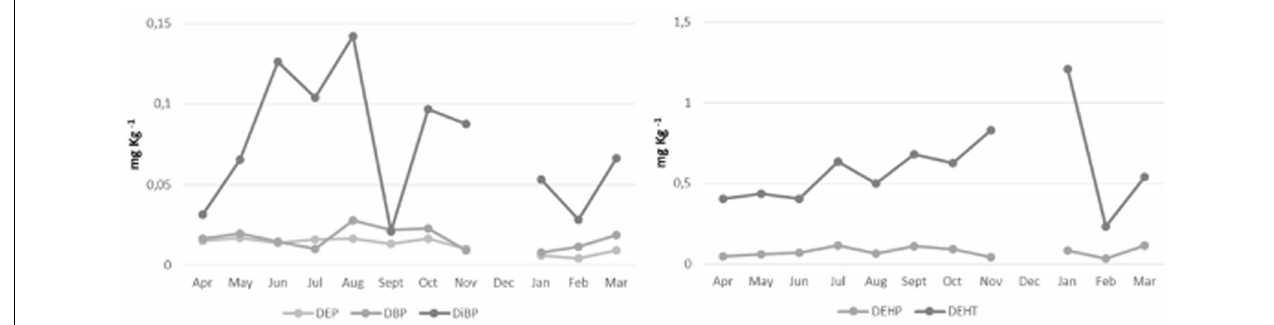
FIGURE 2 | Seasonal variation of single PAE congeners, DEHA and DEHT in the seawater of Mahdia coast (Tunisia) from April 2018 to March 2019.